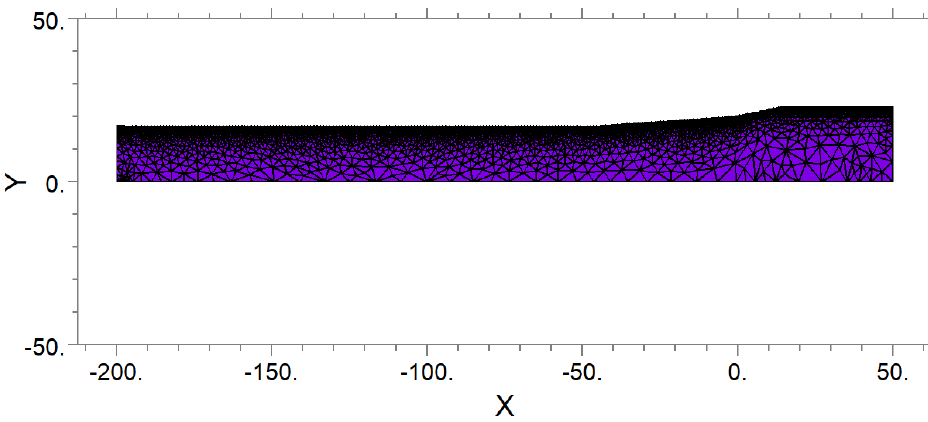
Figure 3. The modeled area with the final computational mesh.